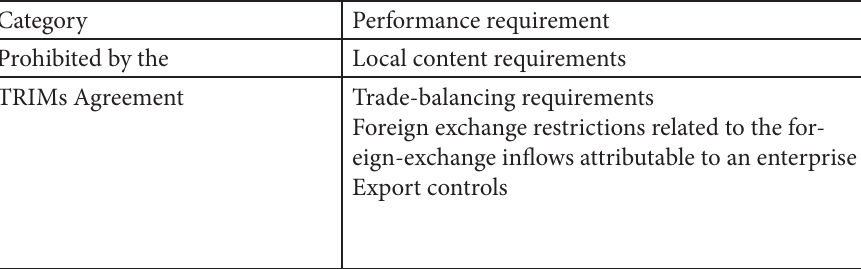
Table 1. Category of performance